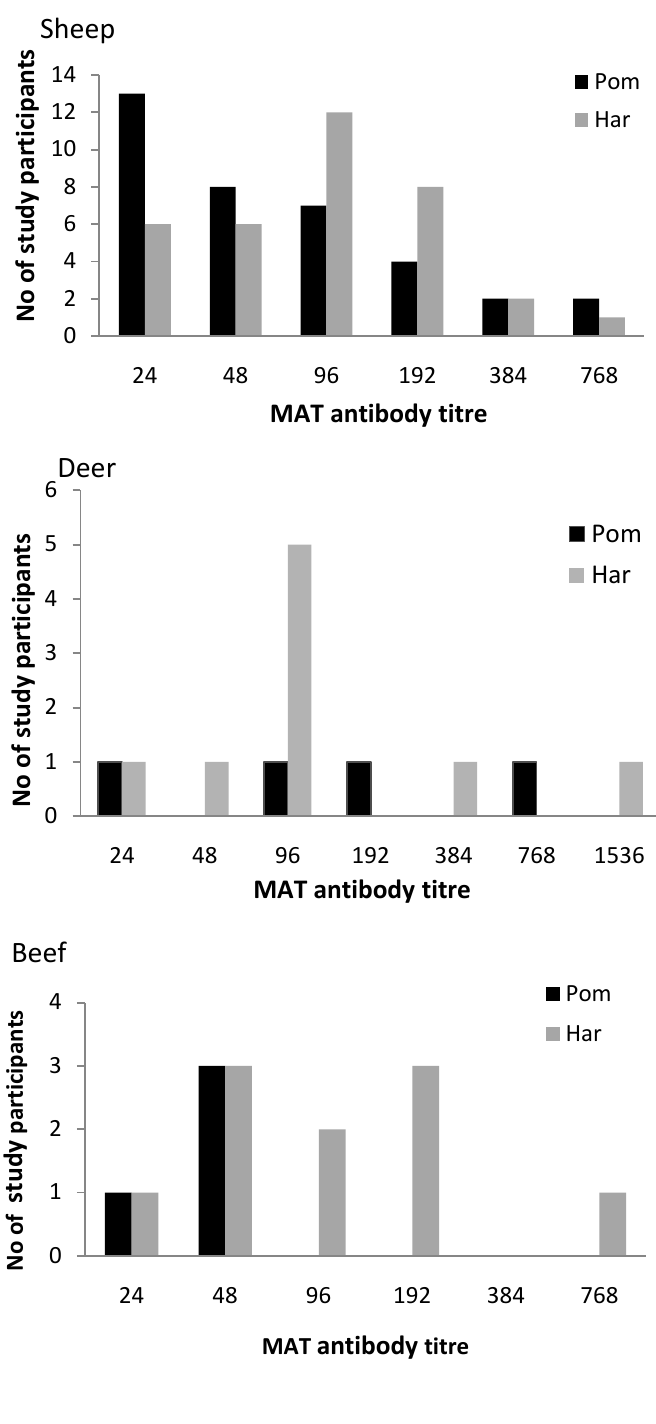
Figure 2. Frequency histogram showing the number of sero-positive study participants at each MAT titre to serovars Leptospira interrogans sv . Pomona (black) and Leptospira borgpetersenii sv . Hardjobovis (grey) in sheep (top), deer (middle) and beef abattoirs